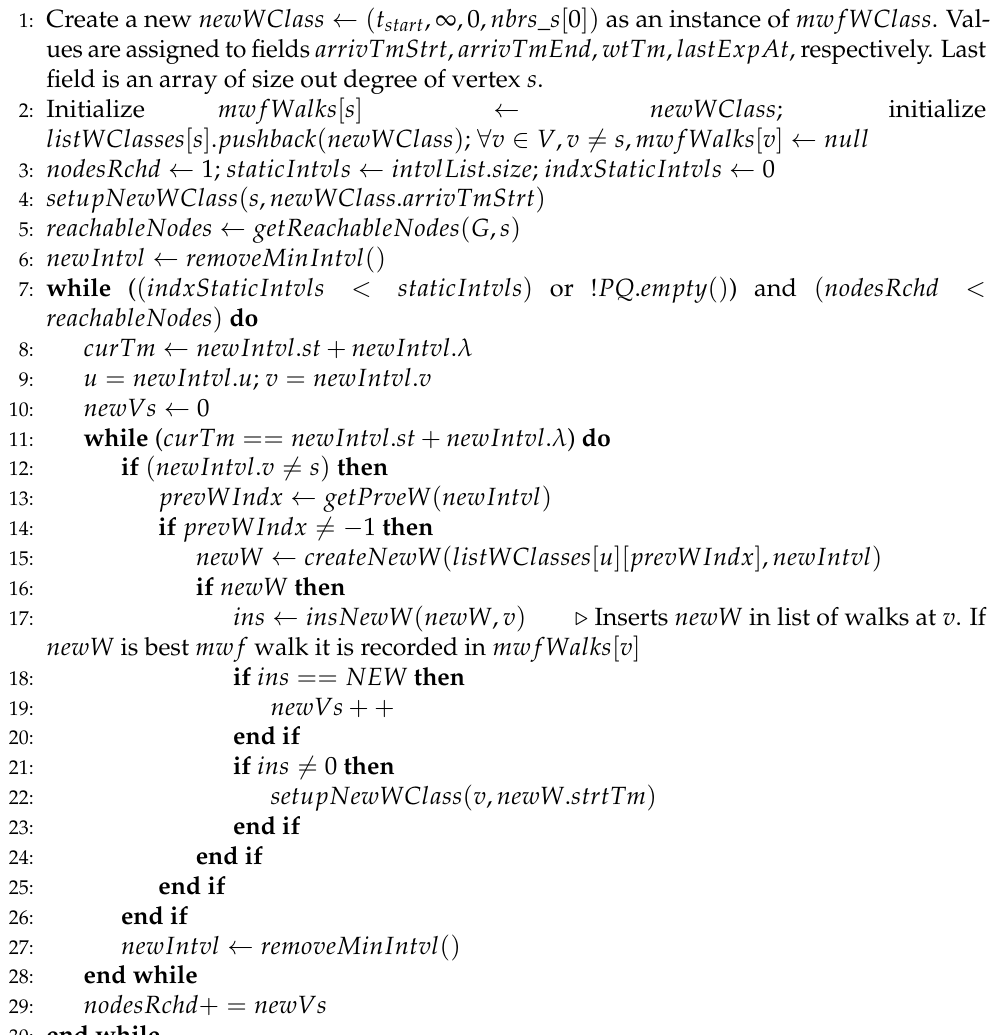
Algorithm 2 Min-wait foremost walks